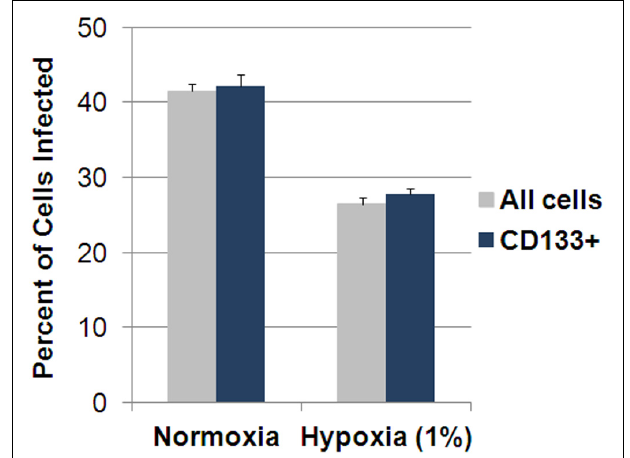
FIGURE 2 | Percentage of pediatric D456MG cells infected in normoxia and hypoxia by a γ 1 34.5-deleted virus 30 h after infection. Cells were infected at 10 PFU/cell by a GFP-expressing γ 1 34.5-deleted virus for 30 h. After the addition of a CD133 allophycocyanin (APC) labeled antibody, cells were analyzed by fluorescent activated cell sorting (FACS) analysis looking for GFP and APC expression.There was a significant decrease in infectivity seen in all cells and CD133 + cells in hypoxia compared to normoxia but a similar number of CD133 + cells were infected compared to all cells in each environment suggesting CD133 + cells were not more